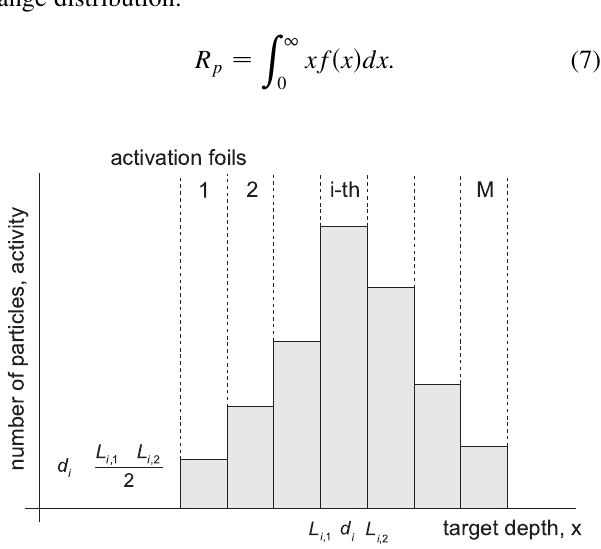
FIG. 1. A schematic range distribution as measured by a depth-profiling